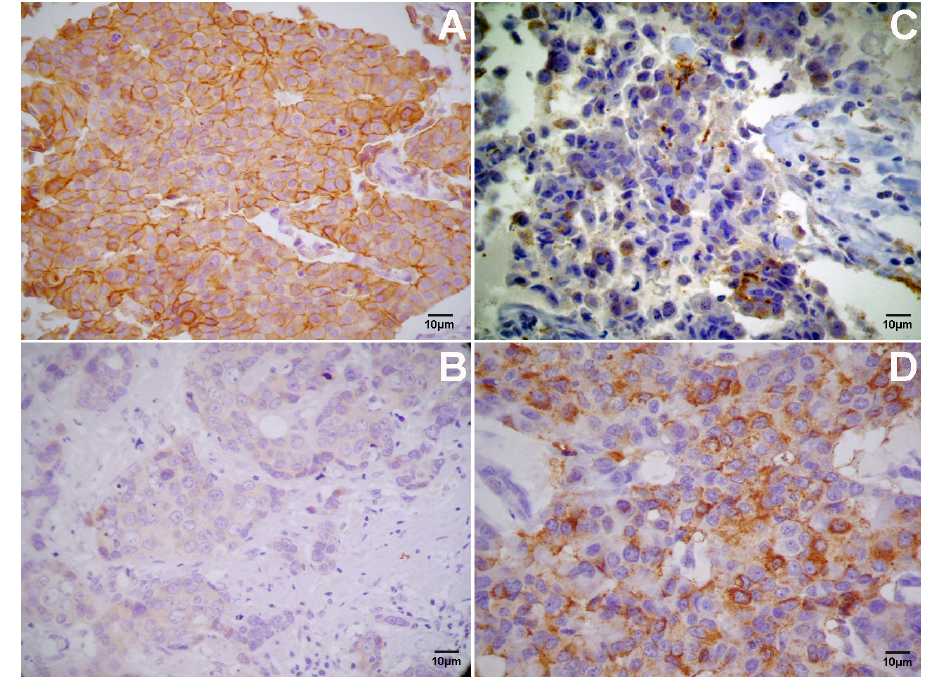
Figure 5. E-cadherin and Snail immunoexpression in breast cancer specimens. A and C , E-cadherin membranous-positive expression in tumor cells and Snail-negative expression in a specimen from a patient from the good prognosis group (Pt 5). B , Negative immuno- staining for E-cadherin in a tumor sample from a patient assigned to the poor prognosis group (Pt 24). D , Snail-positive tumor immu- noexpression in a patient (Pt 9) from the good prognosis group. Snail immunoexpression was mainly observed in the cytoplasm (40X).